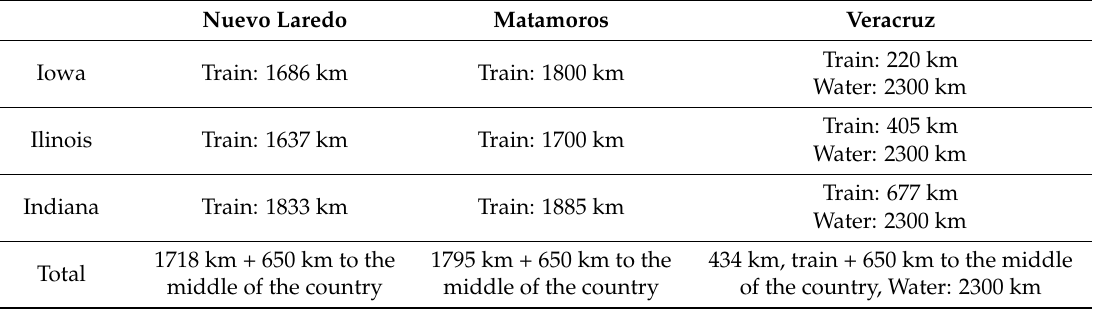
Table 1. Routes and transportation means of the corn from the U.S. to